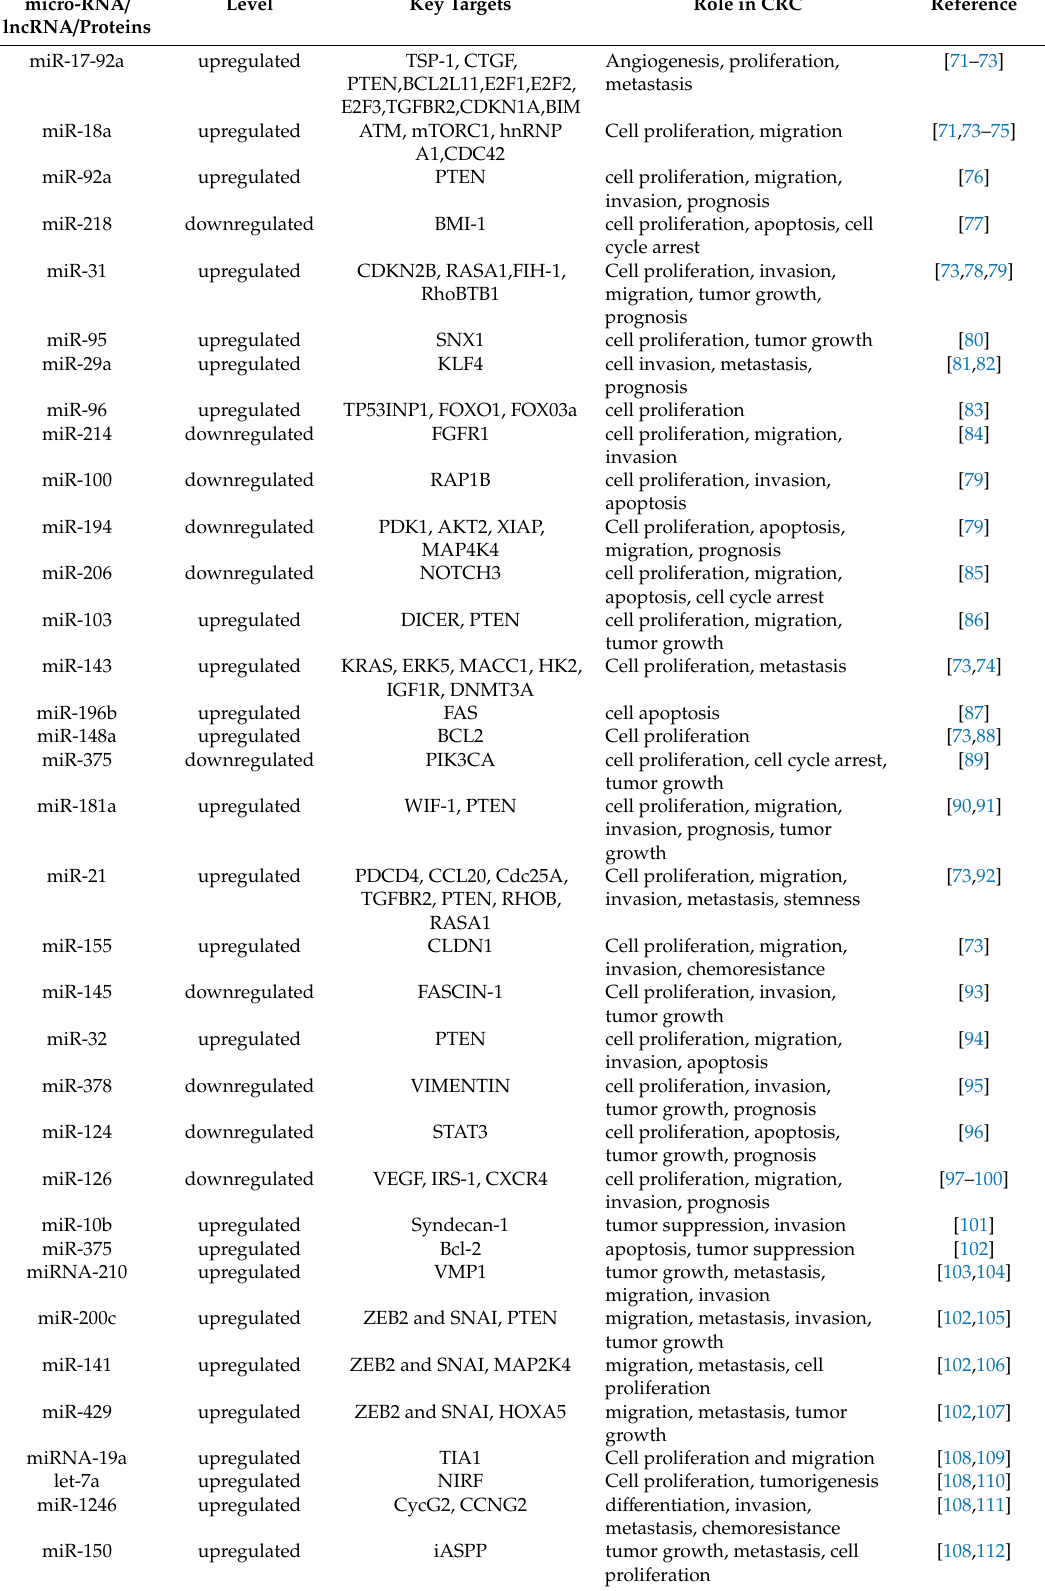
Table 2. Key targets and role of EV derived non-coding RNAs in colorectal cancer. micro-RNA